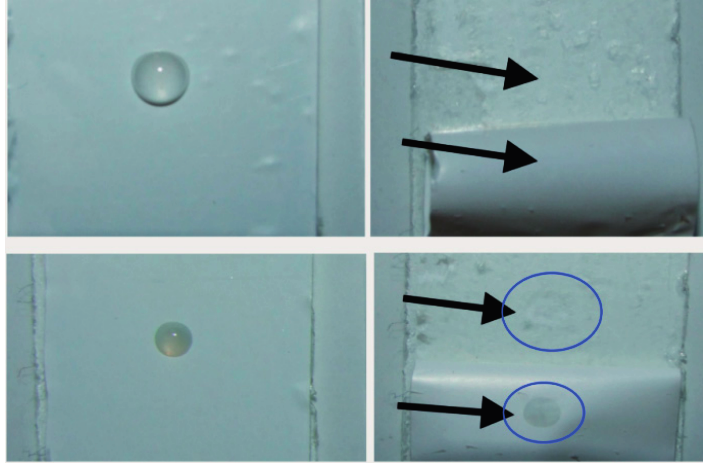
Figure 11. Backside wetting of separator COD-20 by two selected mixtures before ( left ) and after ( right ) pulling the separator off the tape. Above : No wetting is observed in case of mixture M-2; Below : Wetting of the backside can be observed in case of mixture M-1 ( t = 5 min). Arrows and circles are painted for a better illustration of the drops.